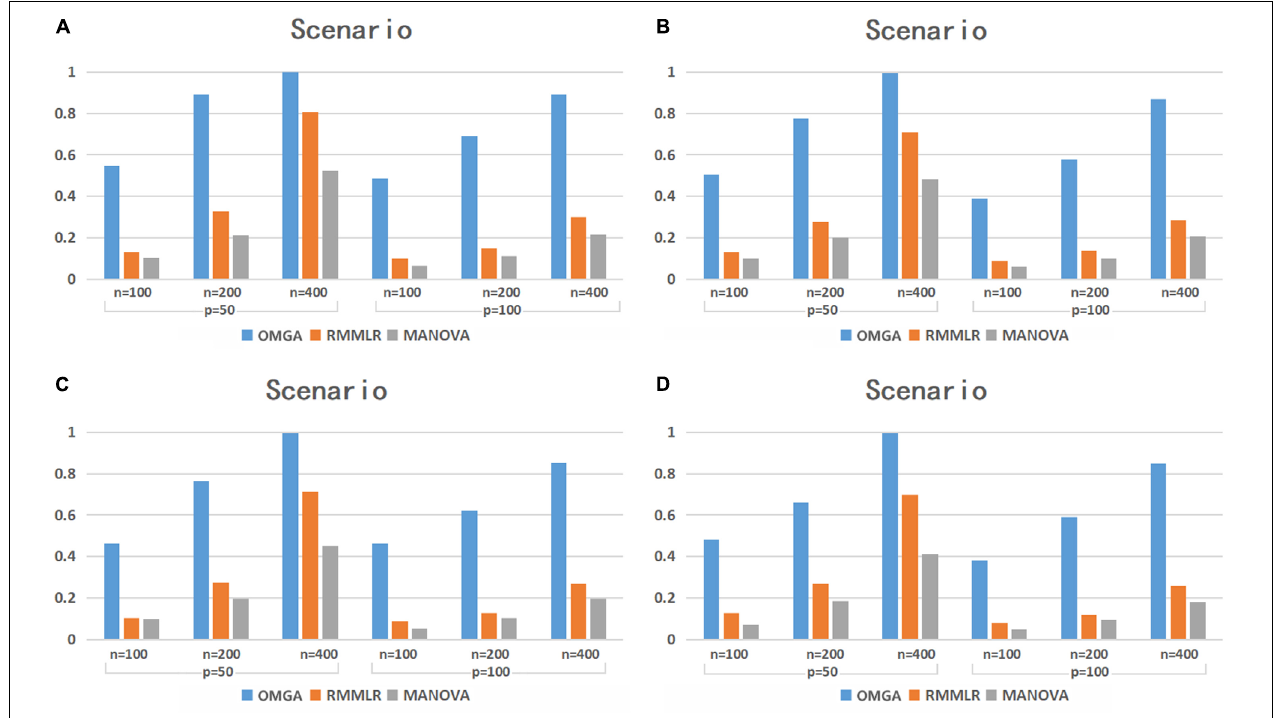
FIGURE 1 | The testing power of different methods under the four scenarios with p = 0.3.